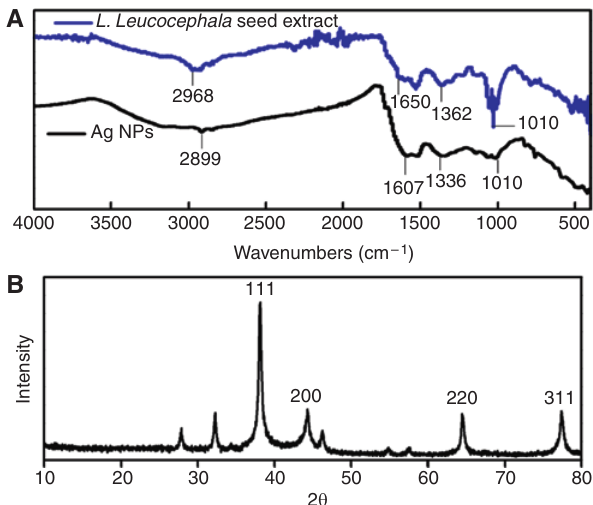
Figure 4: (A) Fourier transform infrared spectroscopy (FTIR) spectra of Leucaena leucocephala seed extract and silver nanoparticles (AgNPs), (B) X-ray diffraction (XRD) spectra of bioreduced AgNPs.